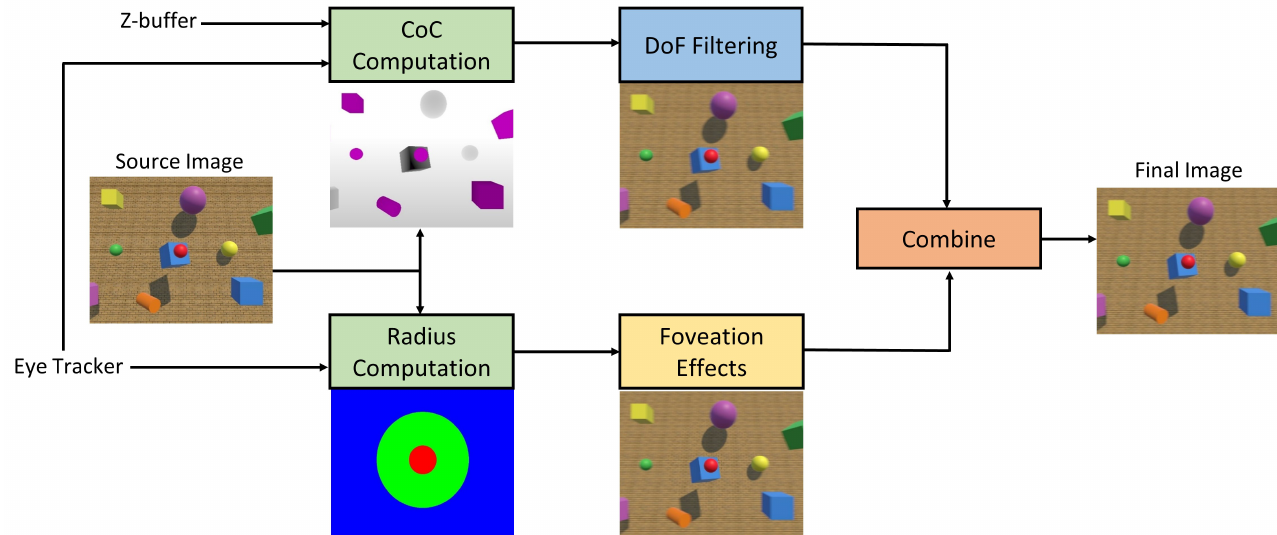
Figure 1. Process flow of the proposed foveated DoF technique showing the intermediate outputs. Fixation is at the center of the red